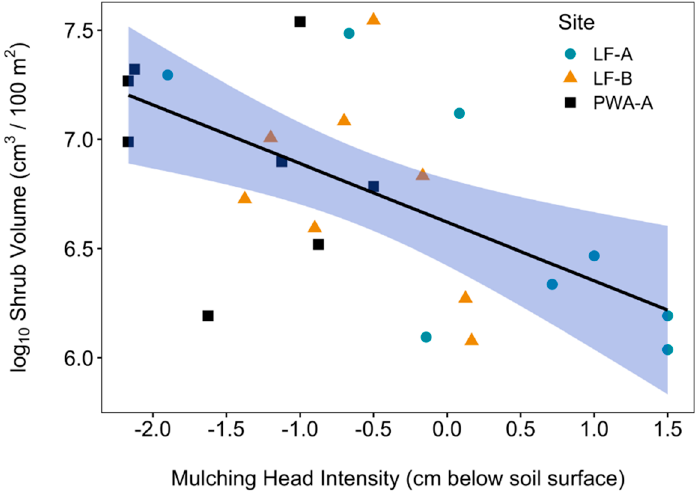
Figure 2. Relationship between mulching head treatment depth and the volume of resprouting shrubs. R 2 = 0.311, p < 0.01. Different symbols correspond to each site and shading indicates the 95% confidence interval. Shrub removal treatments and measurements of resprouting shrubs were conducted in winter and spring 2017, respectively, at three separate sites, near West Lafayette, IN, USA. Sites were located in the same areas (LF and PWA) but were distinct from sites used in comparing mulching head and cut-stump treatments. Negative x-axis values indicate distance above soil surface.